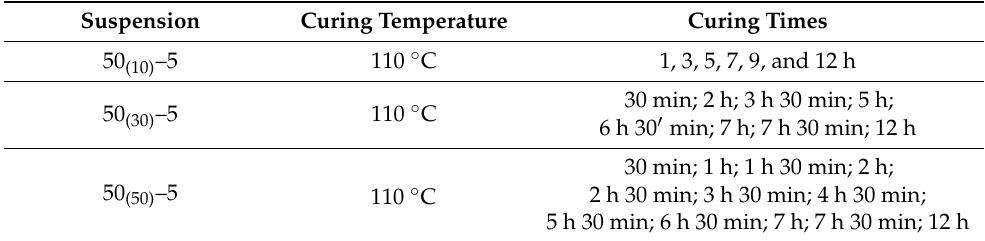
Table 2. Hydrogels tested and experimental conditions of the curing parameters.